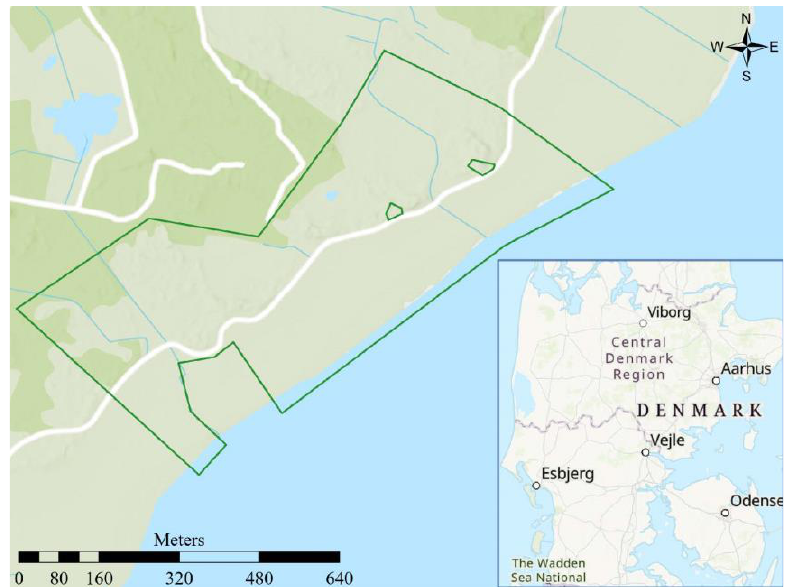
Figure 2. The virtual enclosure the days after the learning period (12 to 15 June 2021). Here, all borders were completely virtual. The coordinates of the lower right corner of the map frame are 8°28′9″ E, 55°23′43″ N.